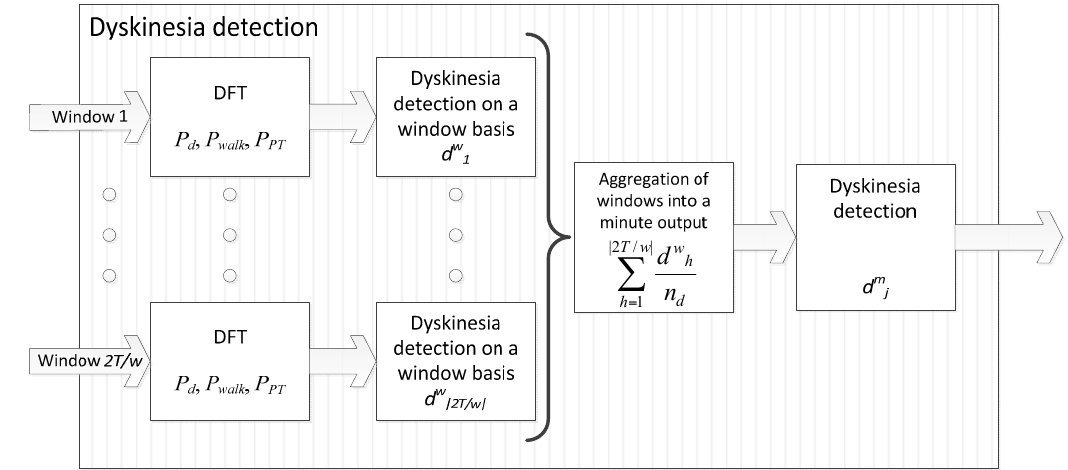
Figure 3. Block diagram of the dyskinesia algorithm.